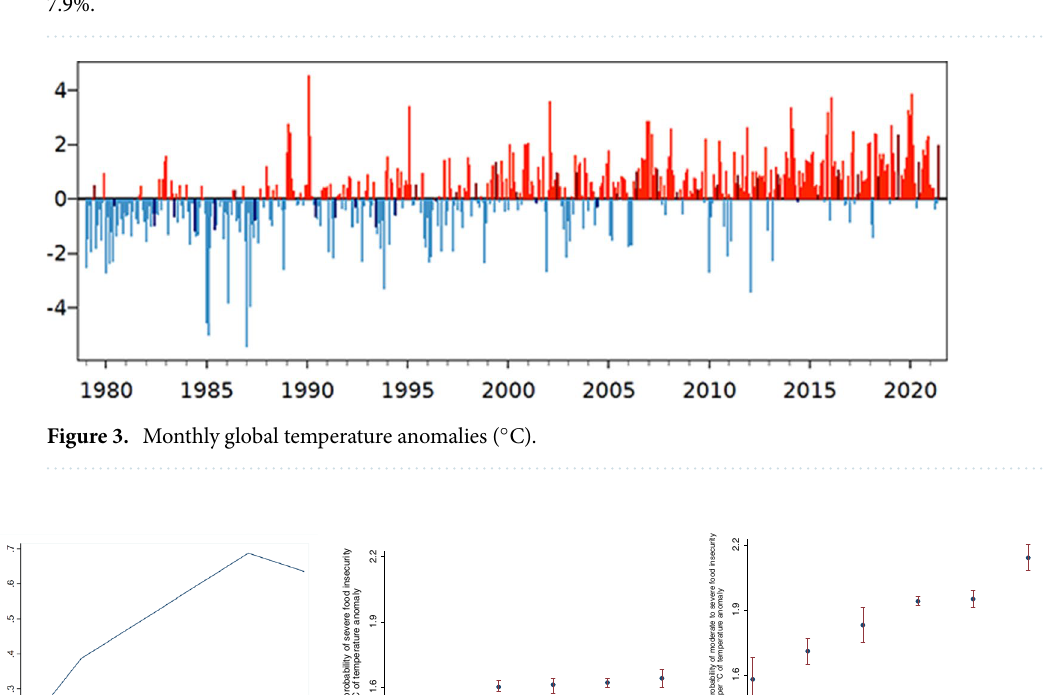
Figure 2. Probability of severe food insecurity (%) across regions. The global average during 2014–2019 was 7.9%.